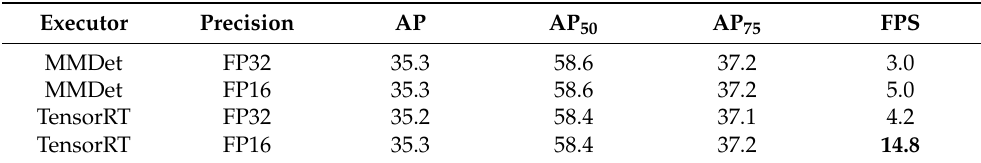
Table 3. Comparing RetinaNet evaluated with MMDetection and TensorRT and different floating point precisions. Both applying TensorRT and reducing the precision to 16 bit is slightly increasing the runtime. However, applying both optimizations increases the runtime by a multiple while not impacting the